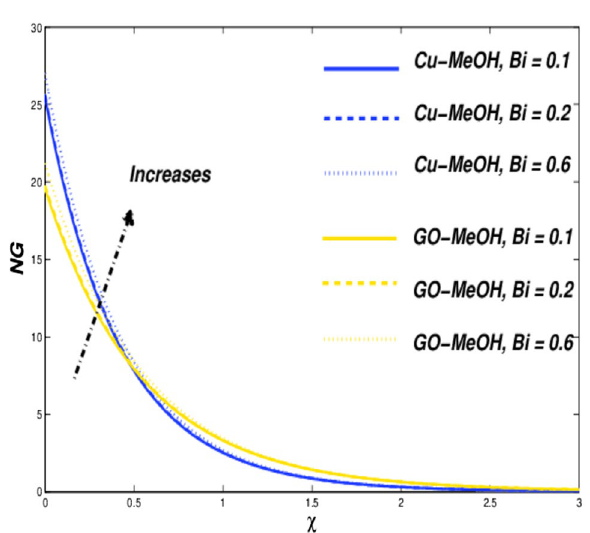
Figure 17. Entropy variation versus Bi